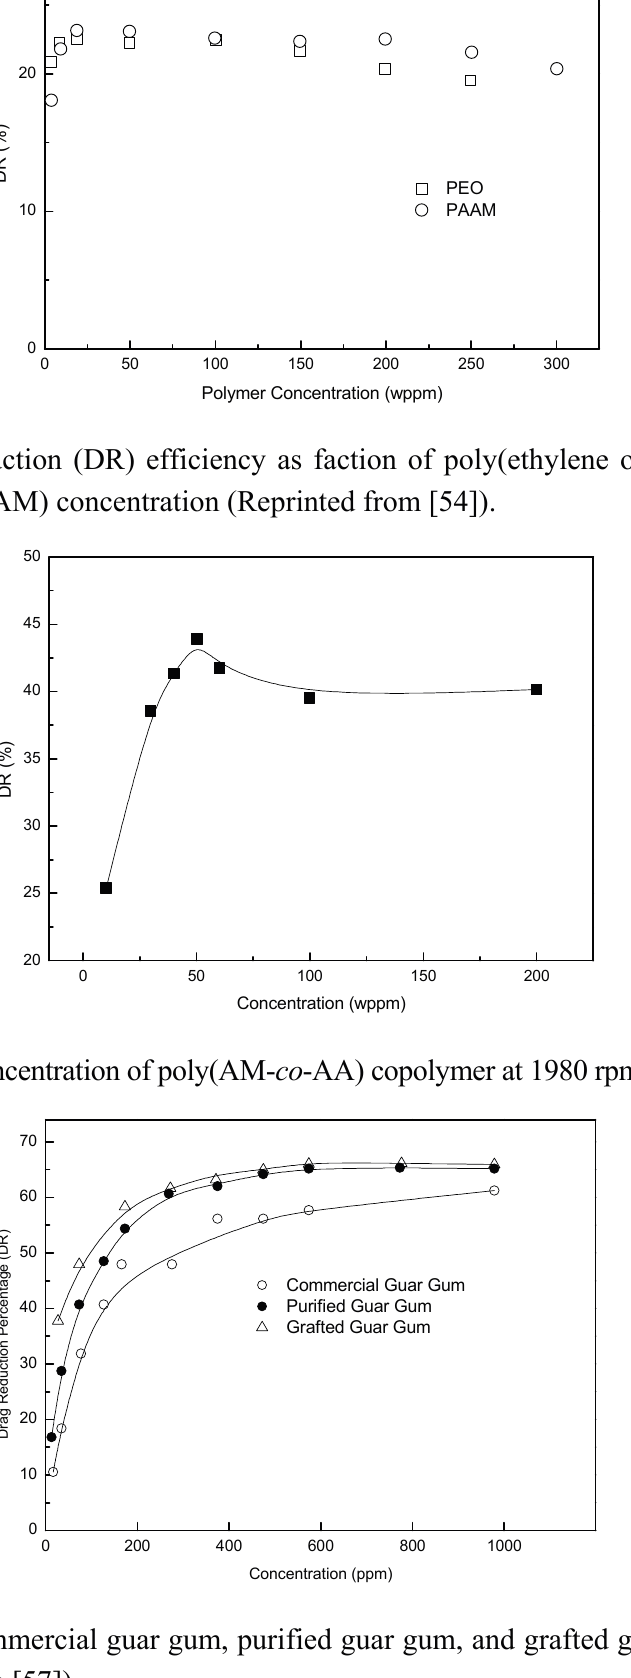
Figure 5. DR of commercial guar gum, purified guar gum, and grafted guar gum in a pipe flow (Reprinted from